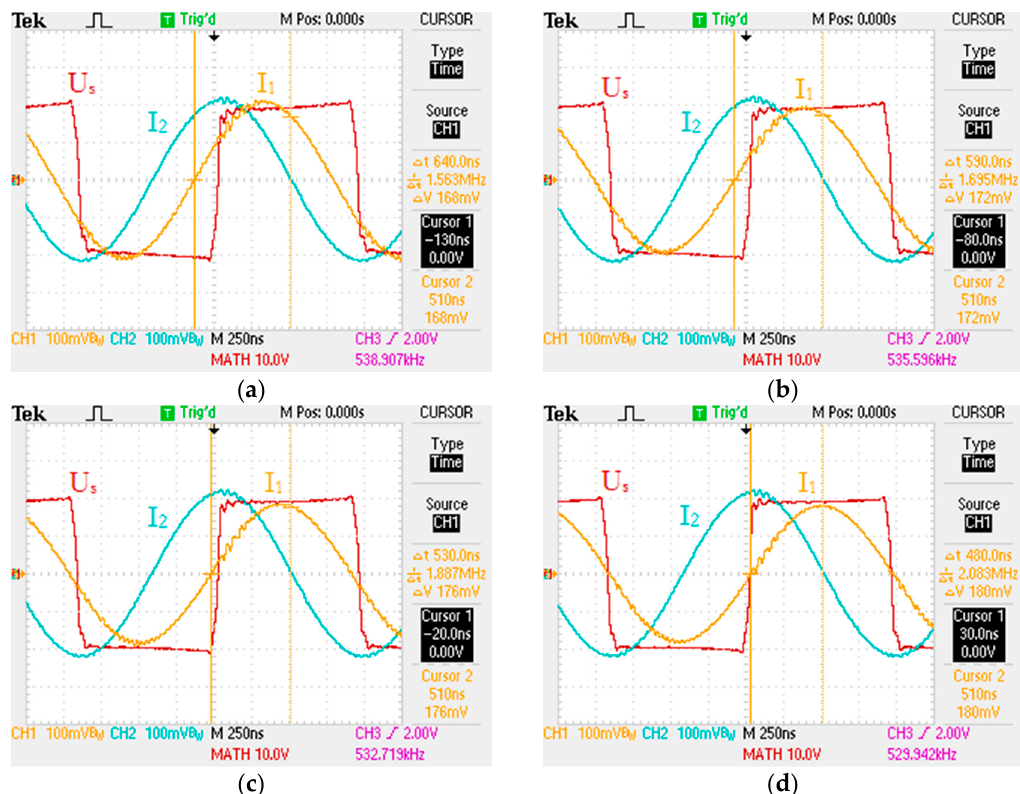
Figure 14. Waveforms of the voltage u s of the inverter, and the currents i 1 and i 2 in the TX and RX during the circuit parameter tuning process. ( a ) C 1 = 1774.4 pF, Δ φ = 56.4°; ( b ) C 1 = 1794.9 pF, Δ φ = 65.9°; ( c ) C 1 = 1816.5 pF, Δ φ = 80.2°; and ( d ) C 1 = 1838.7 pF, Δ φ = 89.4°.